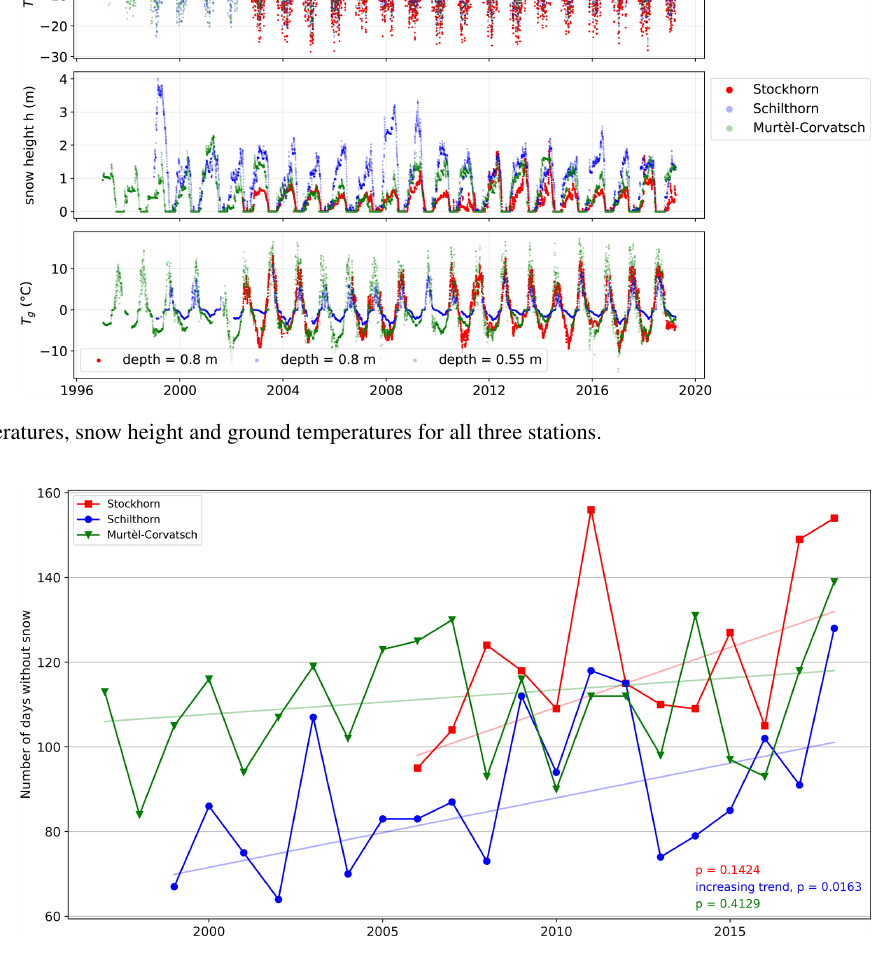
Figure 3. Number of days without snow for the three stations. The tendency to have longer periods without snow is clearly visible. Calculated p values using the Mann–Kendall test show a significant increasing trend in days without snow only for the Schilthorn data (95% confidence interval).